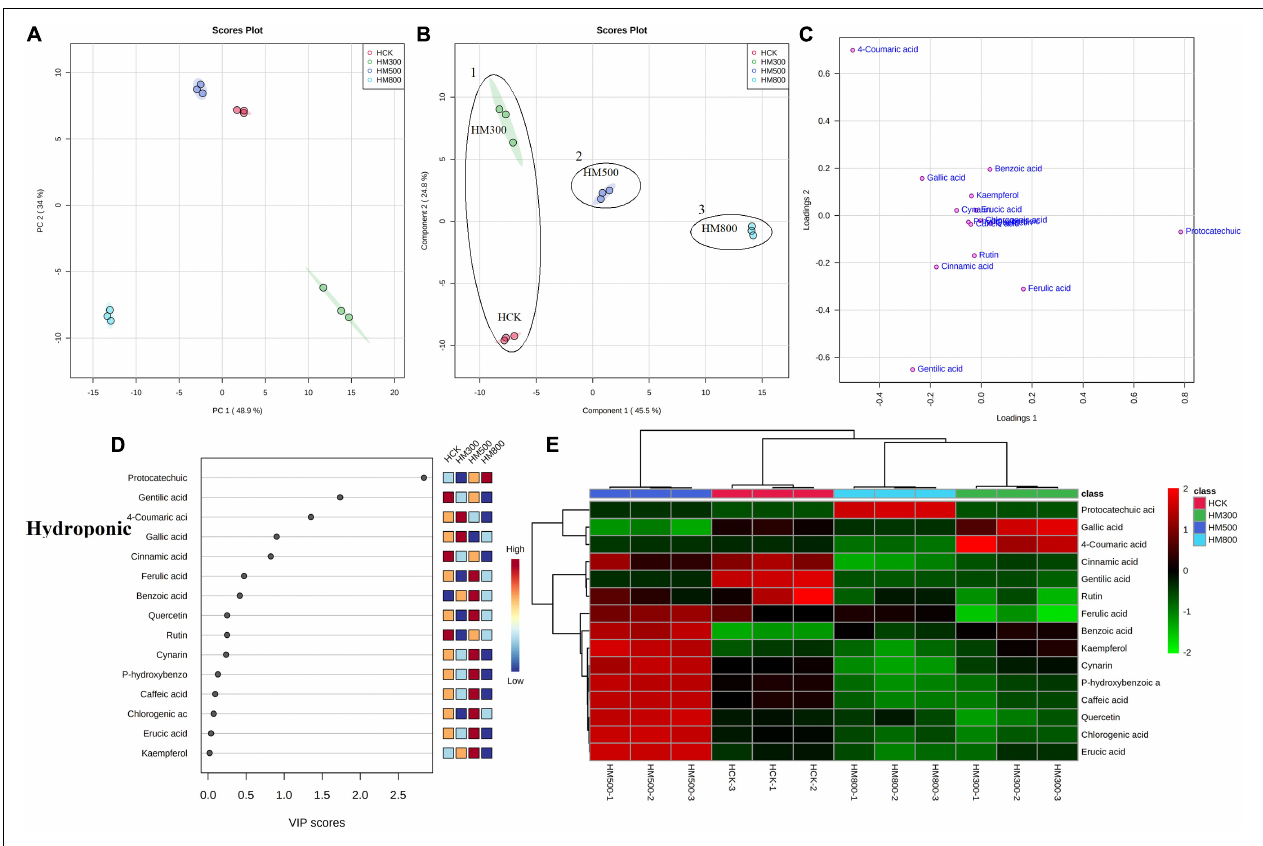
FIGURE 6 | Statistical analyses of bioactive metabolites in hydroponic Chinese chive treated with methyl jasmonate (MeJA). (A) An unsupervised principal component analysis (PCA) score plot of phenolic metabolites. (B) A partial least squares discriminant analysis (PLS-DA) score plot of phenolic metabolites. (C) PLS-DA score plots loaded with different phenolic metabolites. (D) VIP scores of phenolic metabolites in PLS-DA. The scores from low to high determine the importance of variables. The colored boxes on the right show the relative concentration of each metabolite from low (blue) to high (red). (E) Heat map of phenolic concentrations. The colored areas correspond to the concentrations of different amino acids from low (green) to high (red) in groups treated with different concentrations of MeJA. Each row represents a phenolic, and each column represents a